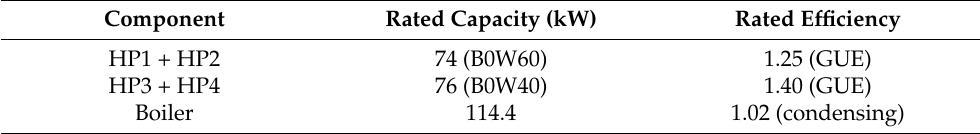
Table 1. Heating generators of the central HVAC